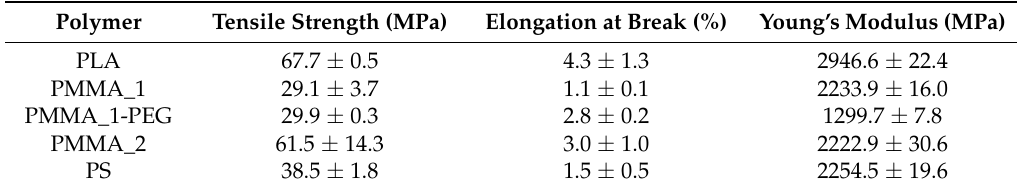
Table 1. Mechanical properties of polymers determined on dog bone specimens.